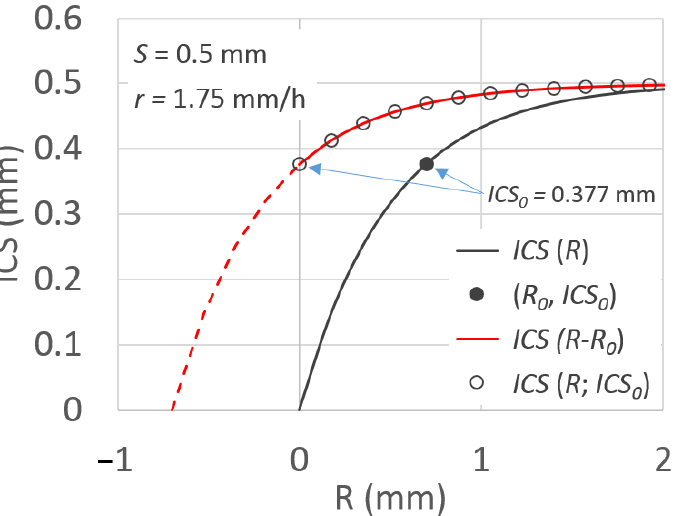
Figure 5. Relationship between the interception storage, ICS (mm), and the rainfall depth, R (mm), for dry antecedent condition, ICS 0 = 0, according to Merrian [18], and for a wet antecedent condi- tion ( ICS 0 = 0.377